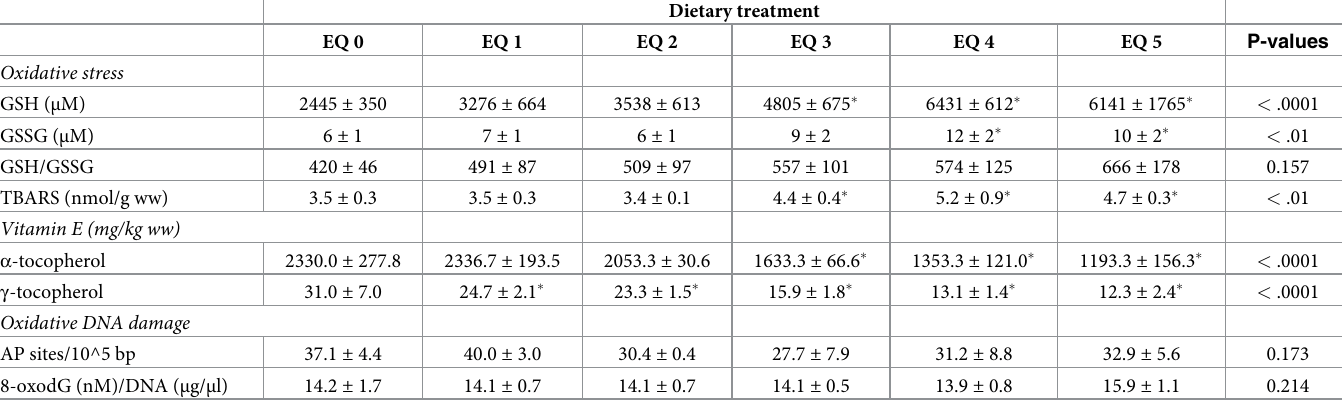
Table 5. Oxidative stress markers and markers for oxidative DNA damage in livers of Atlantic salmon ( Salmo salar L) exposed to graded levels of ethoxyquin (EQ) through their diet for 90